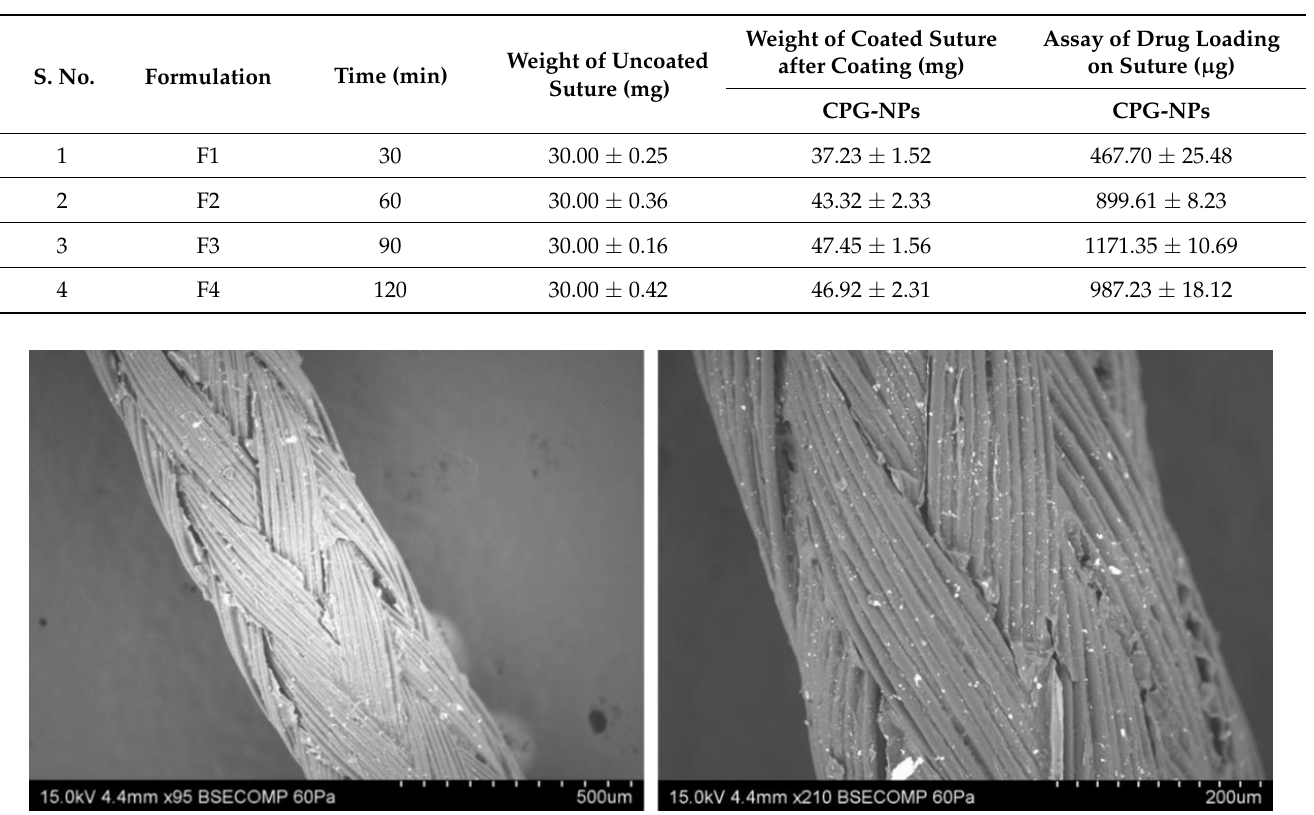
Figure 3. In vitro release profile of CPG-NP-coated sutures (blue lines) and CPH-coated sutures (orange) at different time intervals. 0